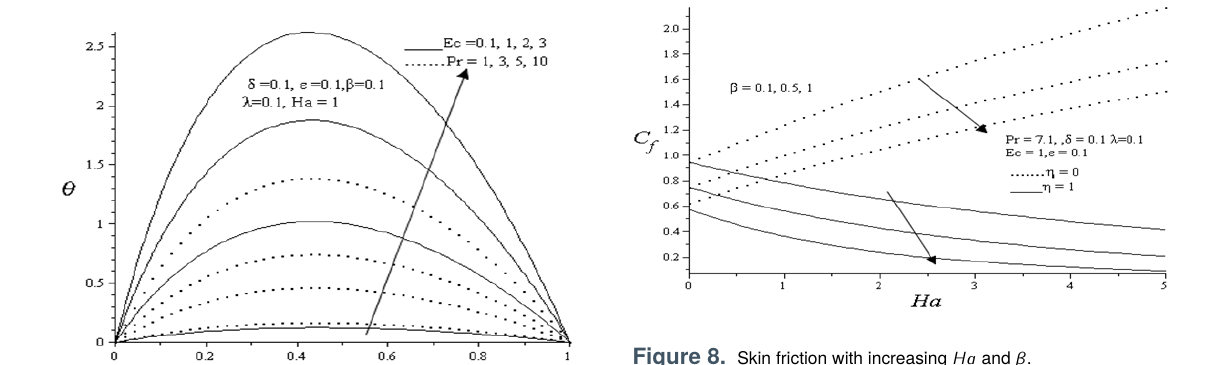
action rate ( λ ) causes an increase in the Nusselt number until the thermal critical value is attained.